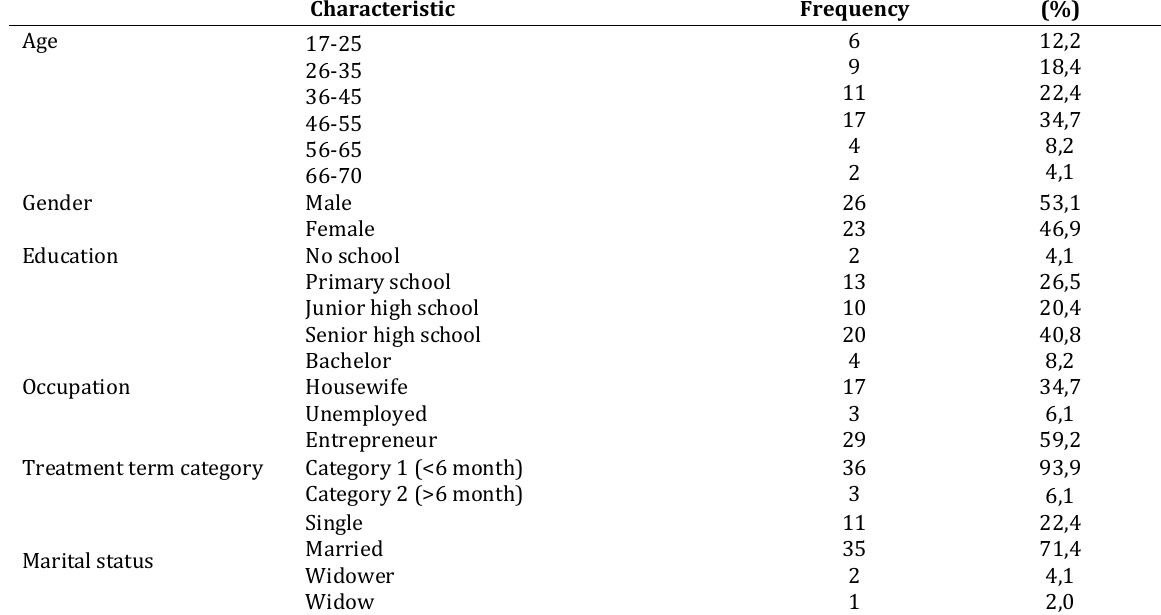
Table 2. Anxiety Level and Spiritual Level of the Pulmonary Tuberculosis Patients in Puskesmas Perak Surabaya (n = 49) Normal Medium anxiety